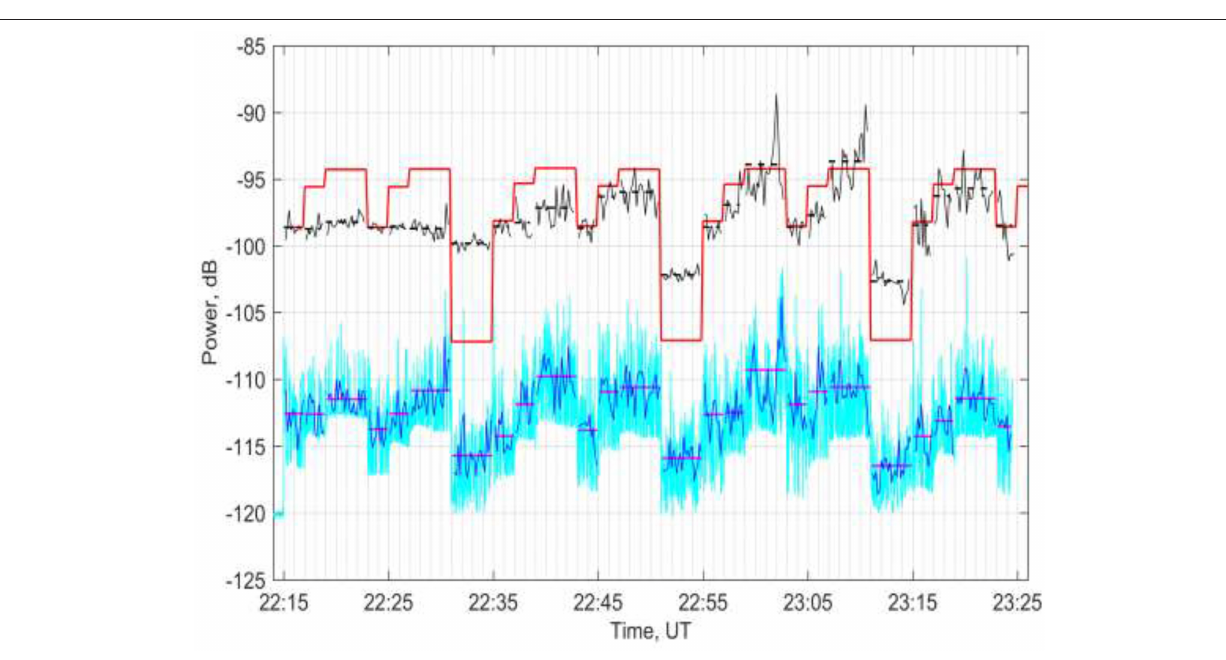
scattering of the Artificial Ionospheric Turbulence excited by the ionospheric heating in the region above the HF facility. Temporal and spatial variations of the AIT region due to the